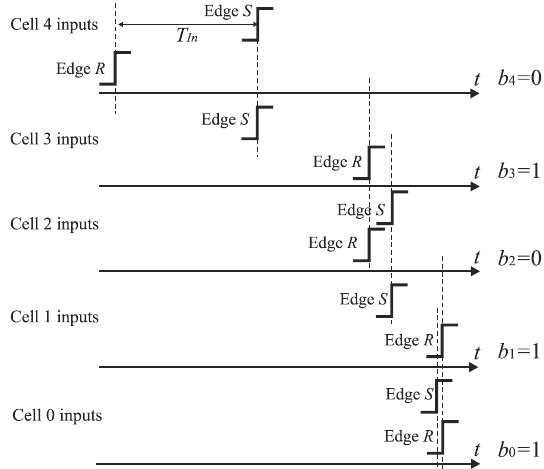
Figure 10. Conceptual model of feedforward type SA-TDC architecture for 5-bits.